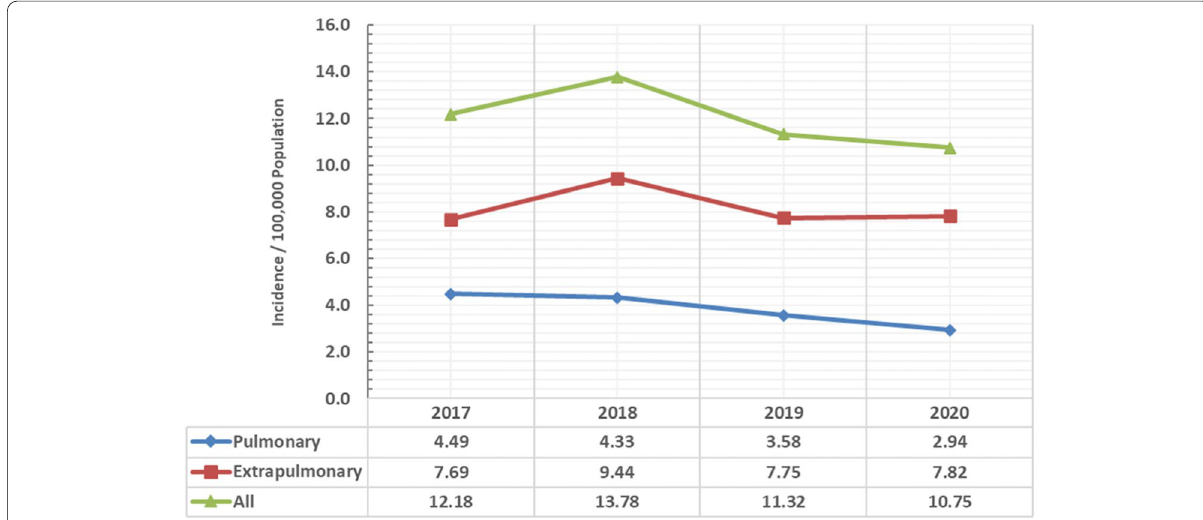
Fig. 1 Yearly TB incidence from 2017 -2020 in Assiut Chest Hospital, Egypt